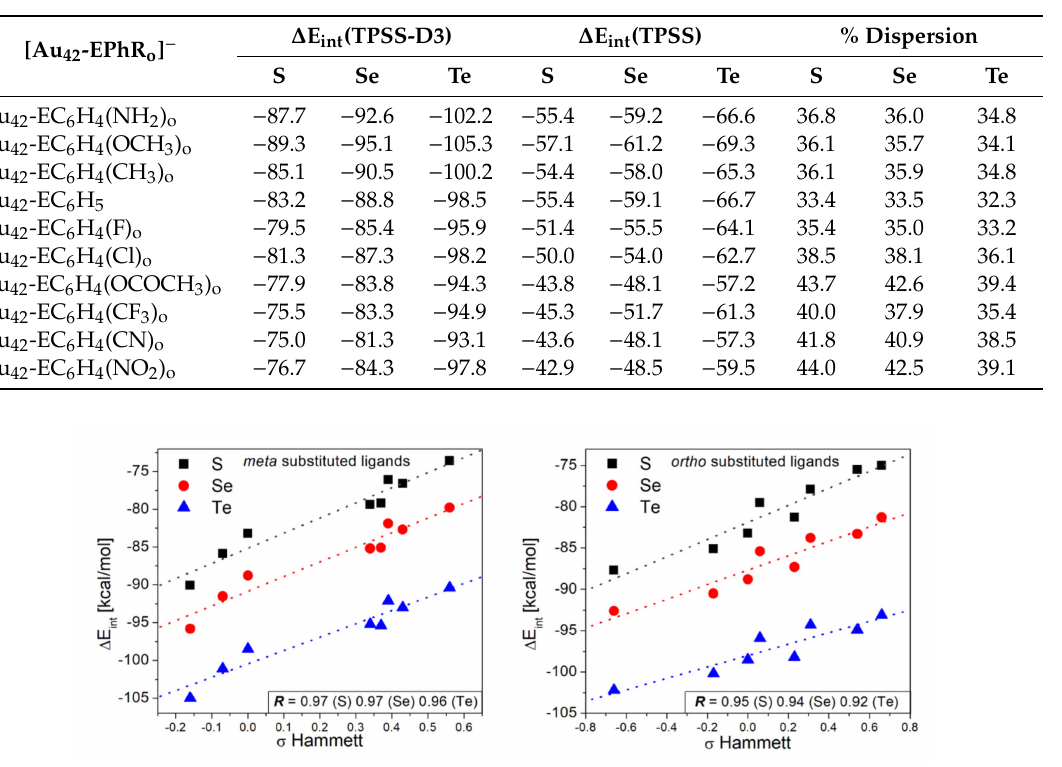
Figure 3. Plot of the interaction energies of the phenyl-chalcogenolates functionalized in meta ( left ) and ortho ( right ) positions versus the Hammett sigma constants σ meta and σ ortho